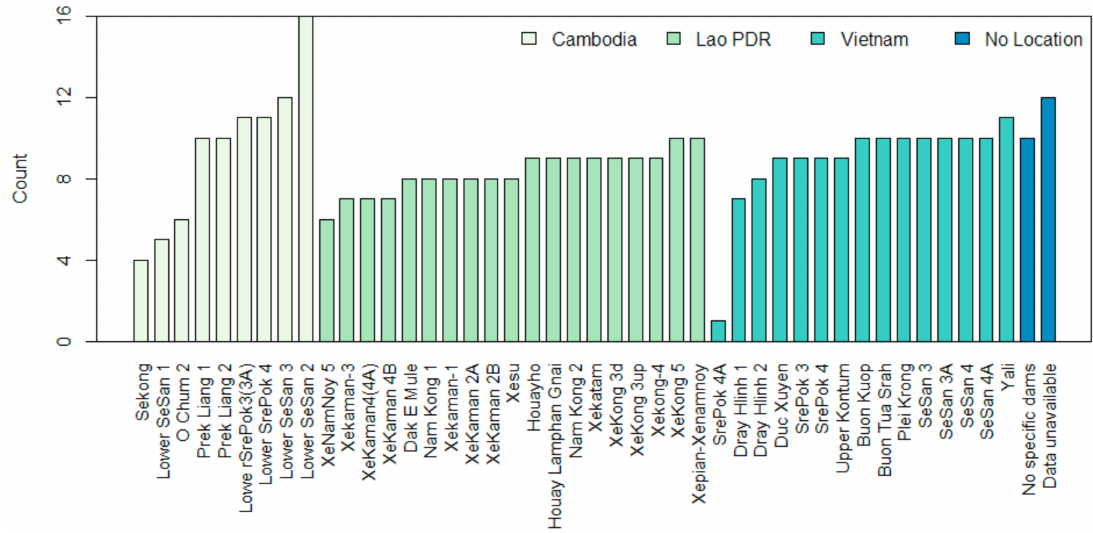
Figure 4. Number of times that 3S dams have been studied.